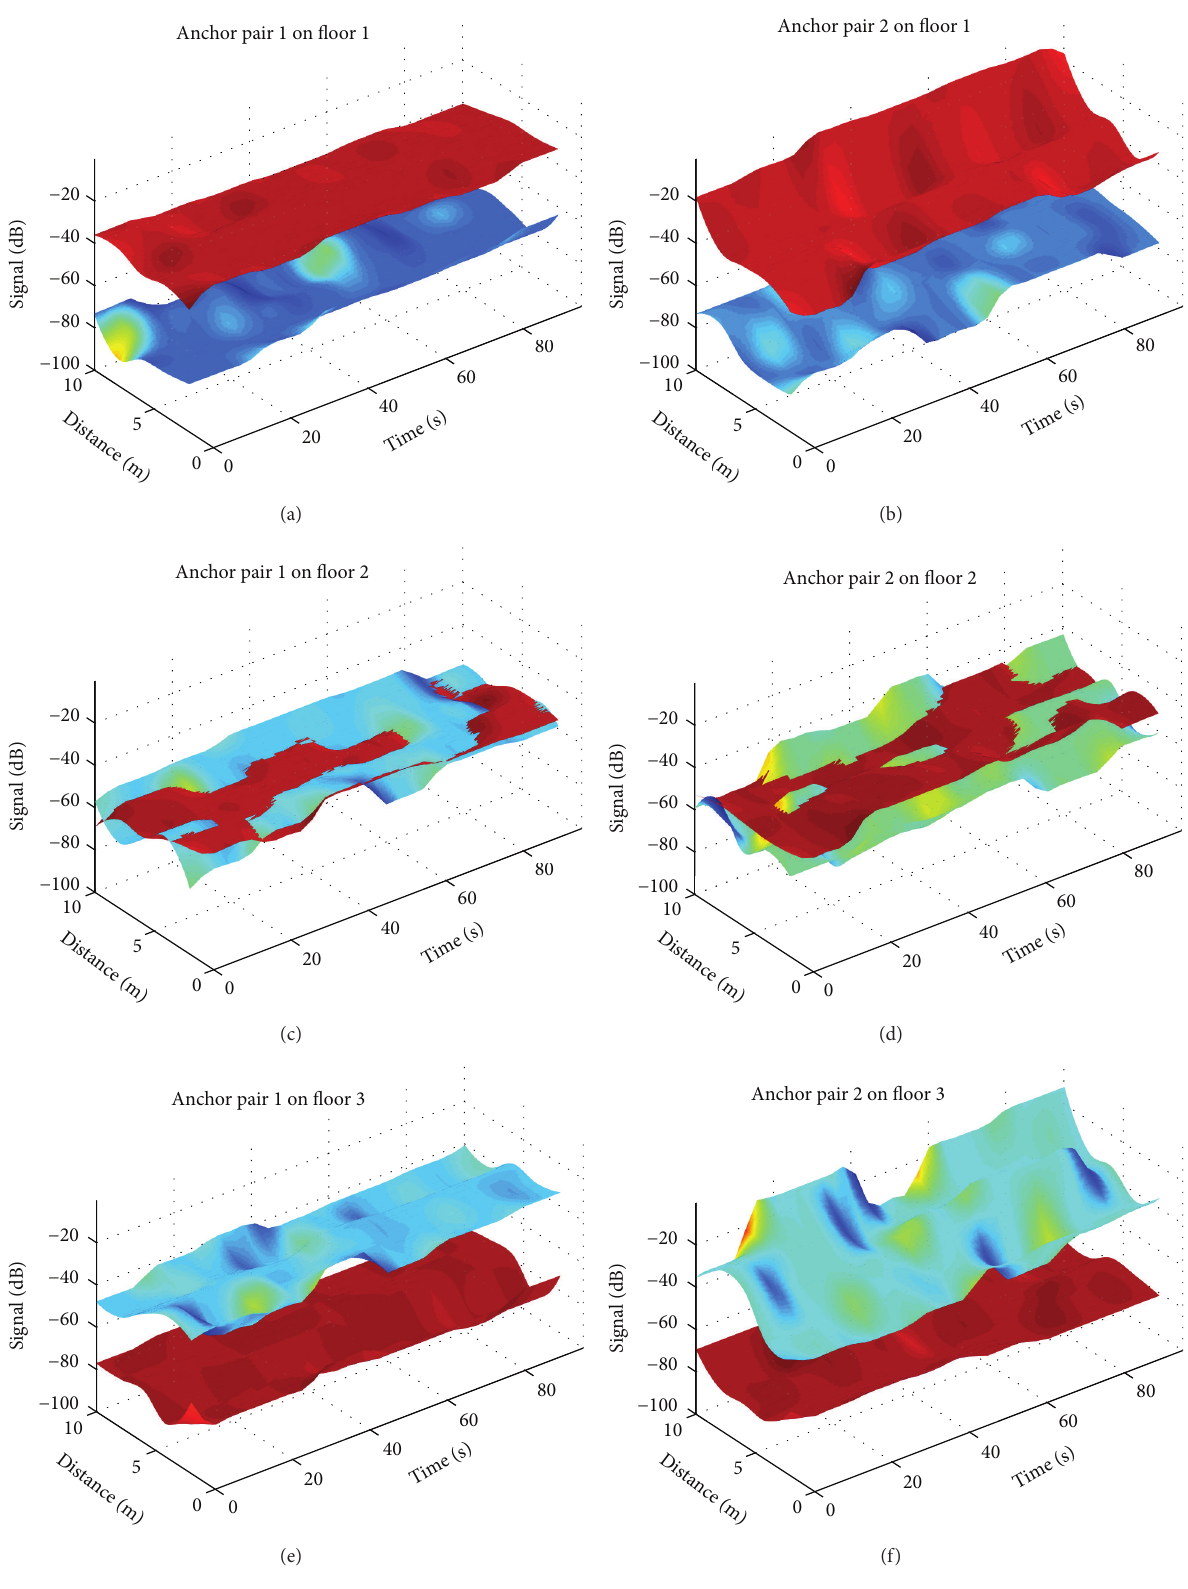
Figure 8: MSD experiment data with 2 anchor